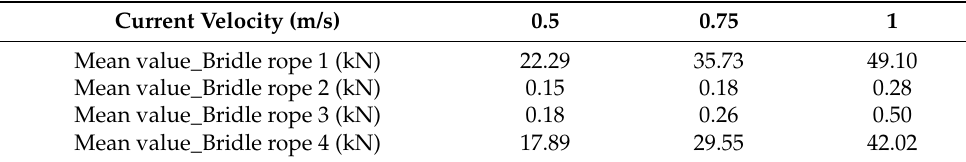
Table 4. Mean values of the maximum mooring force on different bridle ropes. Current Velocity